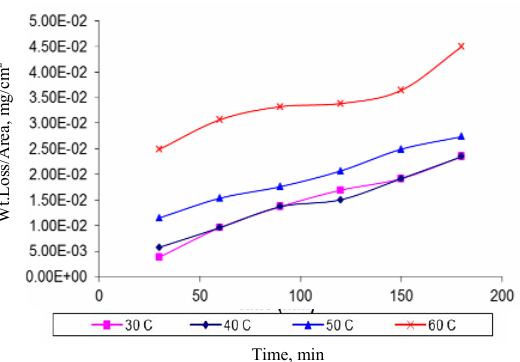
Figure 6. Effect of temperature on corrosion rate in potassium hydroxide = 0.693/k. It was observed that The half - life time values were calculated by formula t 1/2 specific reaction rate, k increases with increase in temperature from 25 °C to 40 °C and corresponding decrease in half - life time takes place (Table 1). It confirms the first order kinetics for the corrosion of iron in sulphuric acid. Table 1. Effect of temperature on corrosion rate in sulphuric acid Size of Iron coupon